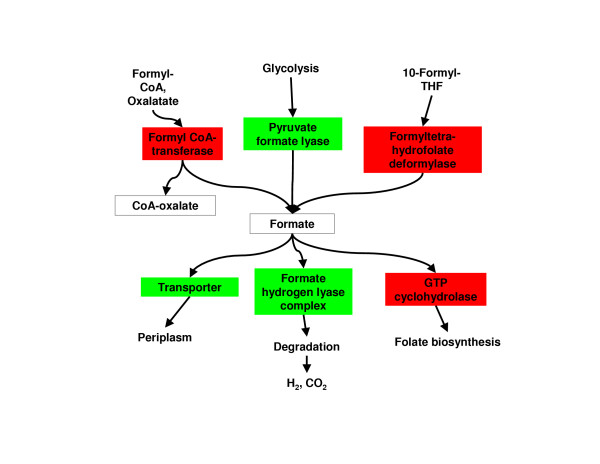
First extracted sub-graph. Green boxes indicate significant up-regulation (p-value ≤ 0.05) under anaerobic conditions. Red boxes indicate significant down-regulation and grey boxes non-significant differential regulation. Red/green frames of grey boxes indicate a non-significant tendency. Glucose is catabolised into pyruvate. Under anaerobic conditions, pyruvate is degraded to formic acid (formate), which is either expelled (via transporters), or further degraded into H2 and CO2. The reactions for these processes were up-regulated whereas the biosynthesis and degradation of costly compounds were down-regulated (folate and 10-formyl-THF, respectively).